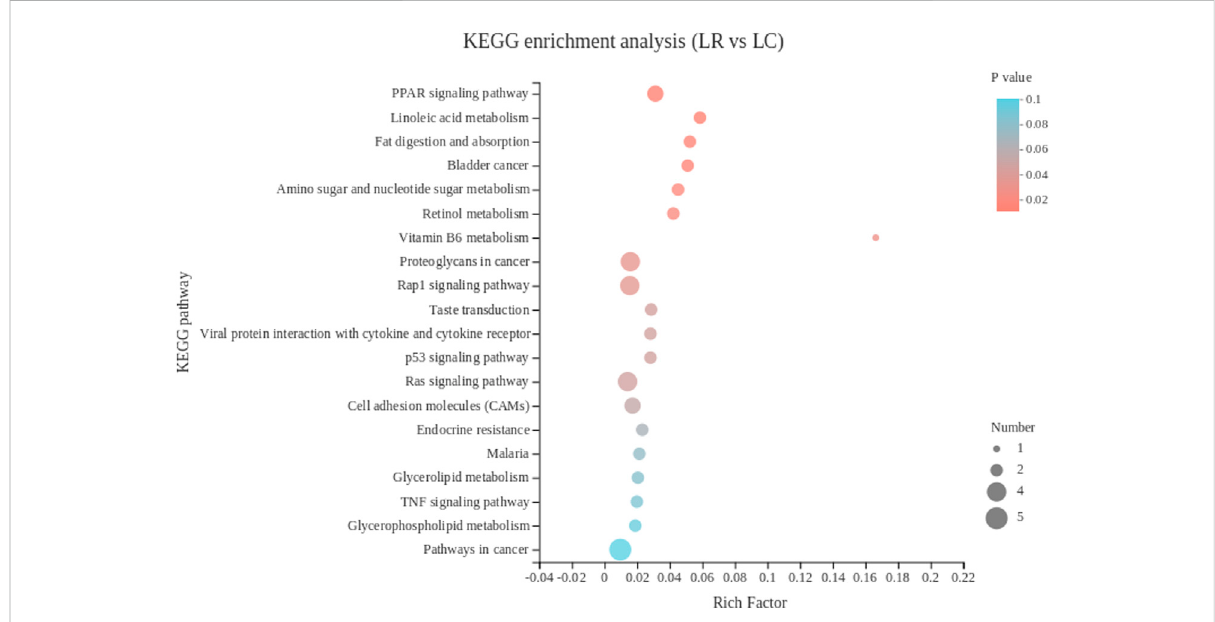
FIGURE 2 Thetop20KyotoEncyclopediaofGenesandGenomespathwaysofDEGsinliver.Thecolorofthedotrepresentsthe p value,andthesizeofthe dot represents the number of DEGs enriched in the reference pathway. LR, liver of rooster; LC, liver of